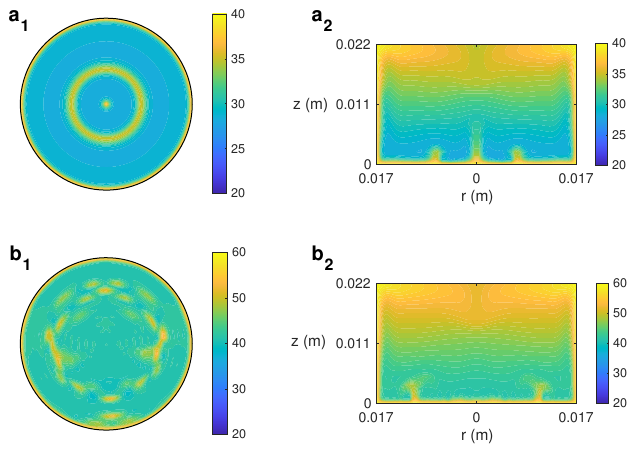
Figure 4. Contour of the predicted temperature at t = 40 s for the case Ω = 0 s − 1 . ( a ) T e = 40 ◦ C. ( a 1 ) Top view at z = 0.0017 m; ( a 2 ) r − z section at φ = 0 ( φ = π ) ; ( b ) T e = 60 ◦ C. ( b 1 ) Top view at z = 0.0017 m; ( b 2 ) r − z section at φ = 0 ( φ = π )